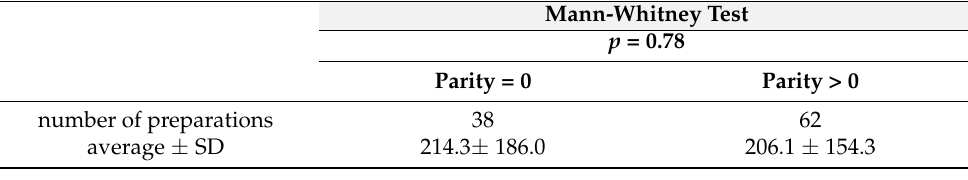
Table 3. The expression of the SNHG4 gene in relation to the number of parity (Mann–Whitney test; p > 0.05).